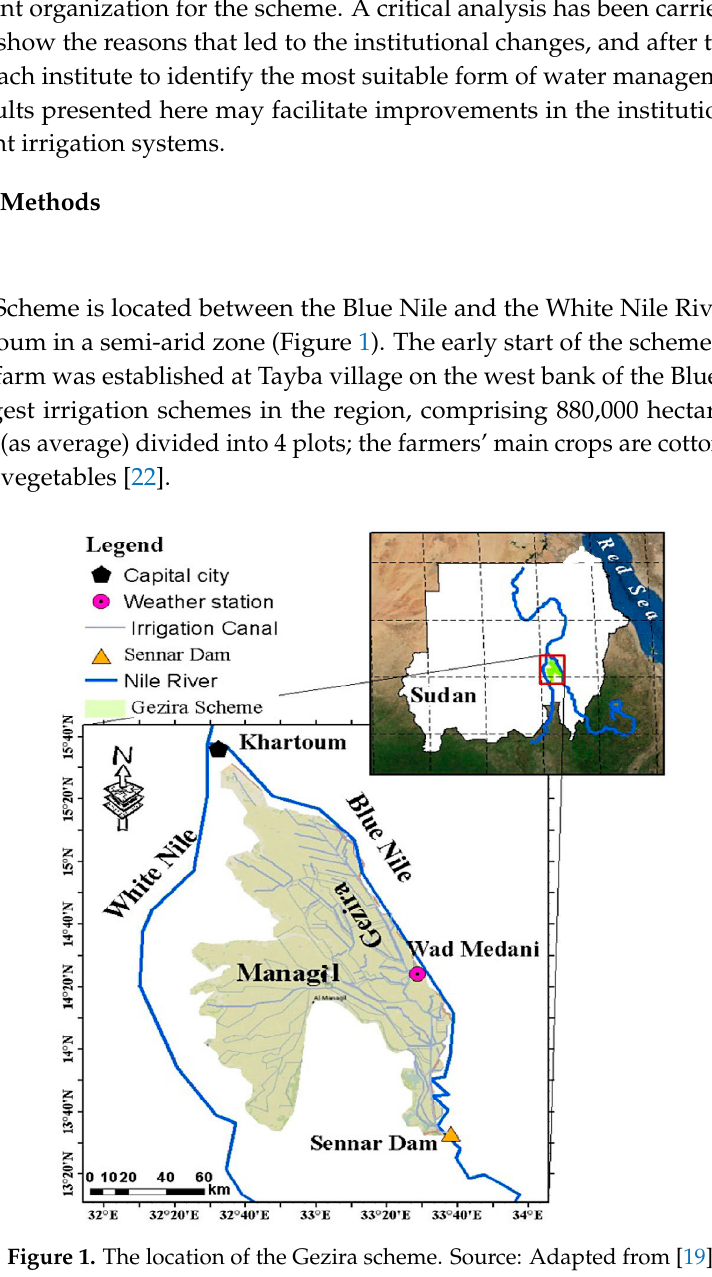
Figure 1. The location of the Gezira scheme. Source: Adapted from [19].